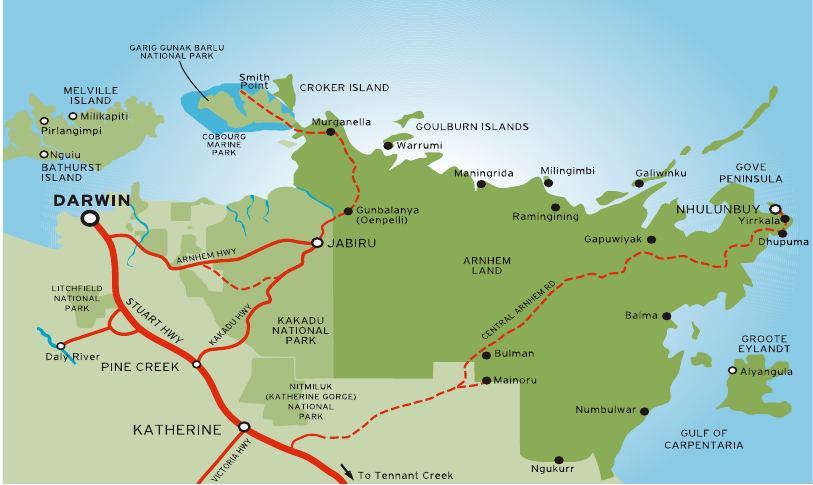
Figure 2. Arnhem Land (shown as the darkened section, including surrounding islands), Northern Territory, Australia. Image sourced from https://northernterritory.com .